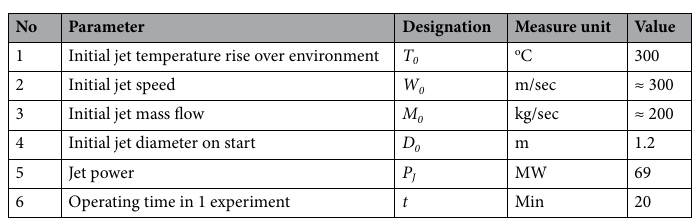
Table 1. Parameters of the jet initiated by the experimental device.